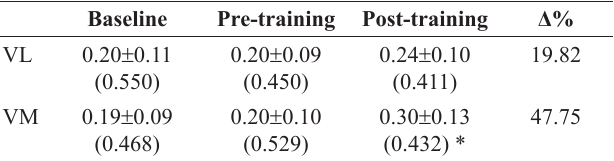
2. Muscle activity values [in mV; mean ± standard deviation (coefficient of variation)] from vastus lateralis (VL) and vastus me- dialis (VM) during the control period and after the 12-week isokinetic eccentric training